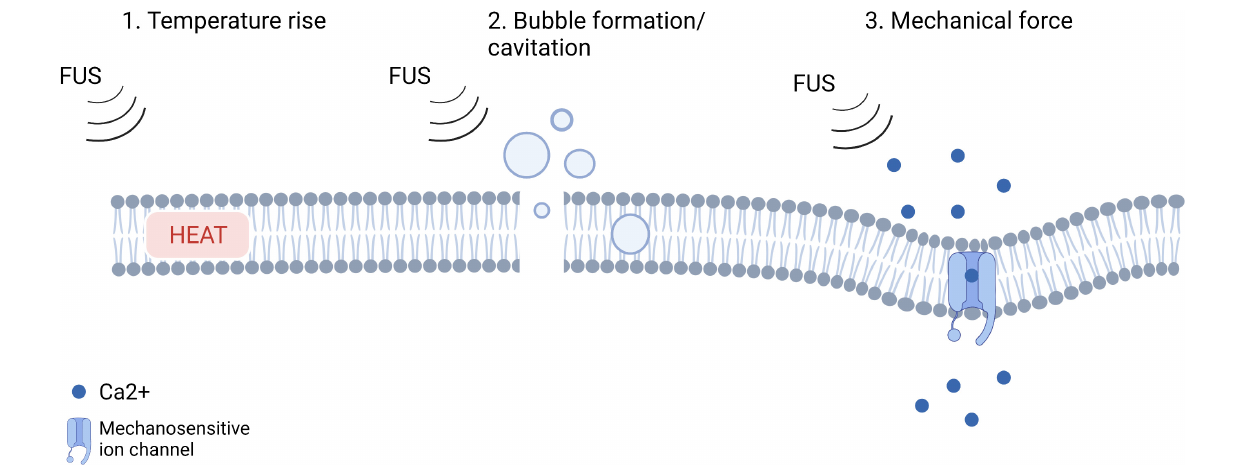
FIGURE 1 | An illustration of the hypotheses regarding the mechanism of action of LIFU (adjusted from Yoo et al., 2022; Created with